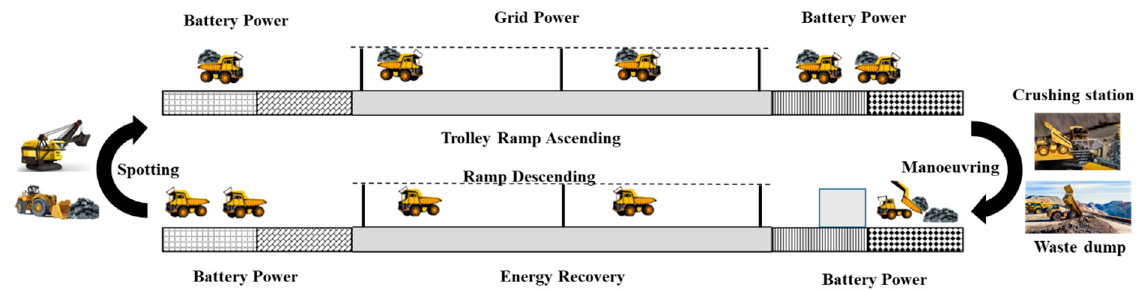
Figure 18. A schematic of dual trolley BT systems power source.